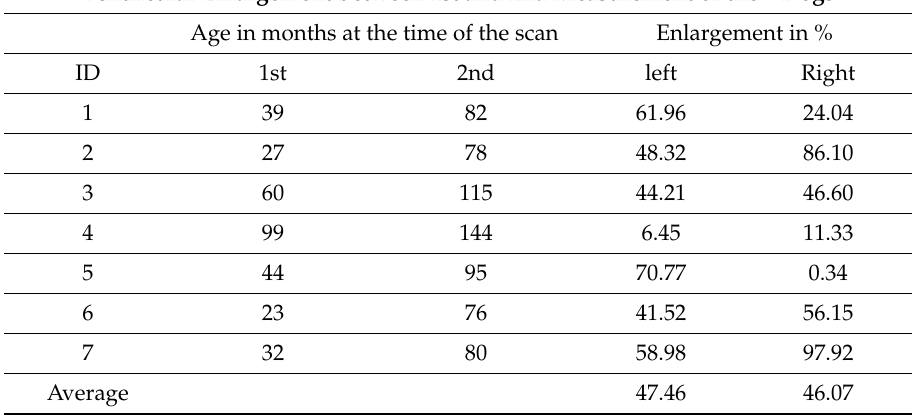
Table 1. Ventricle volumes (left and right) of the seven dogs presented individually and in sum. The enlargement is expressed in percentage comparing volume measured at the 1st and the 2nd